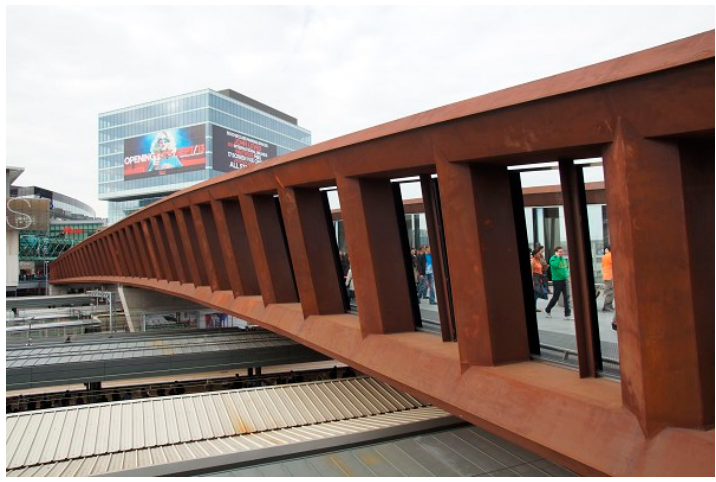
Figure 7. Town Centre Link Bridge at Stratford (UK). Photo: N. Janberg (reproduced with permission from Structurae [7], 2011).